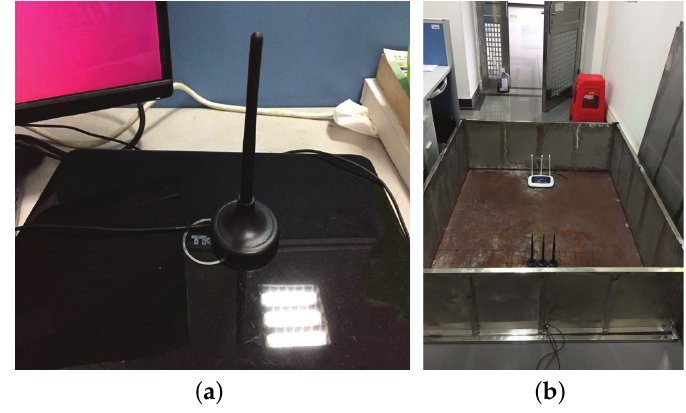
Figure 6. Experimental equipment. ( a ) A DELL laptop equipped with Intel 5300 NIC. ( b ) Metal